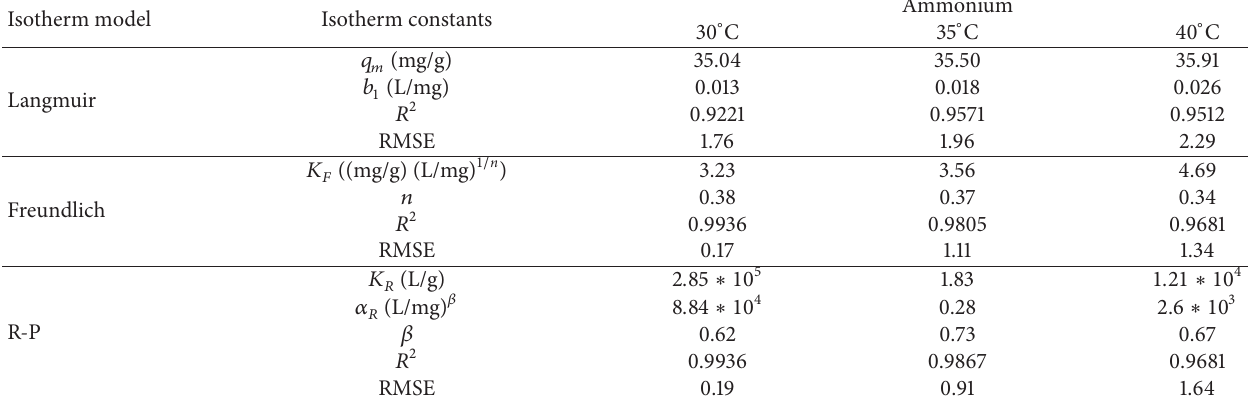
Table 1: Isotherm parameters of ammoniacal nitrogen adsorption on X/AC at different temperatures. Isotherm model